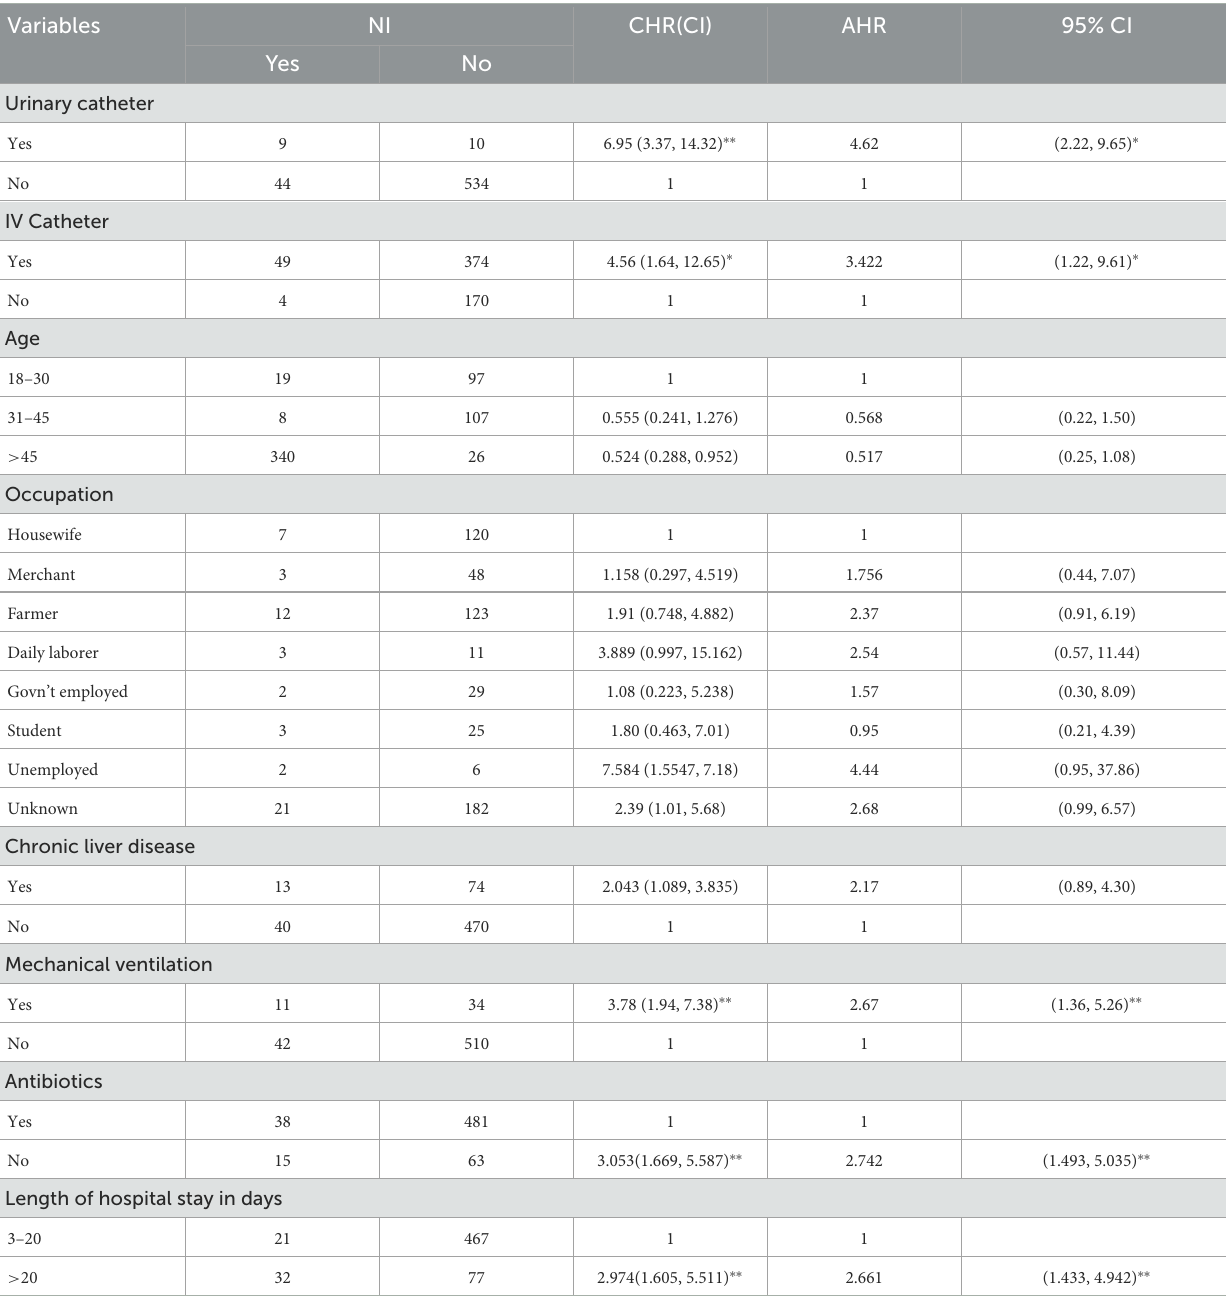
TABLE 3 Factors affecting the occurrence of nosocomial infection among adult chronic illness patients admitted at University of Gondar Comprehensive Specialized Hospital, Northwest Ethiopia, 2016–2020 ( N = 597).